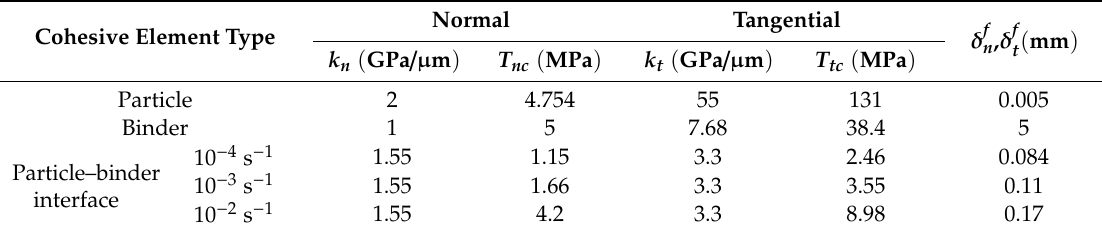
Table 2. Parameters for the three types of cohesive elements.